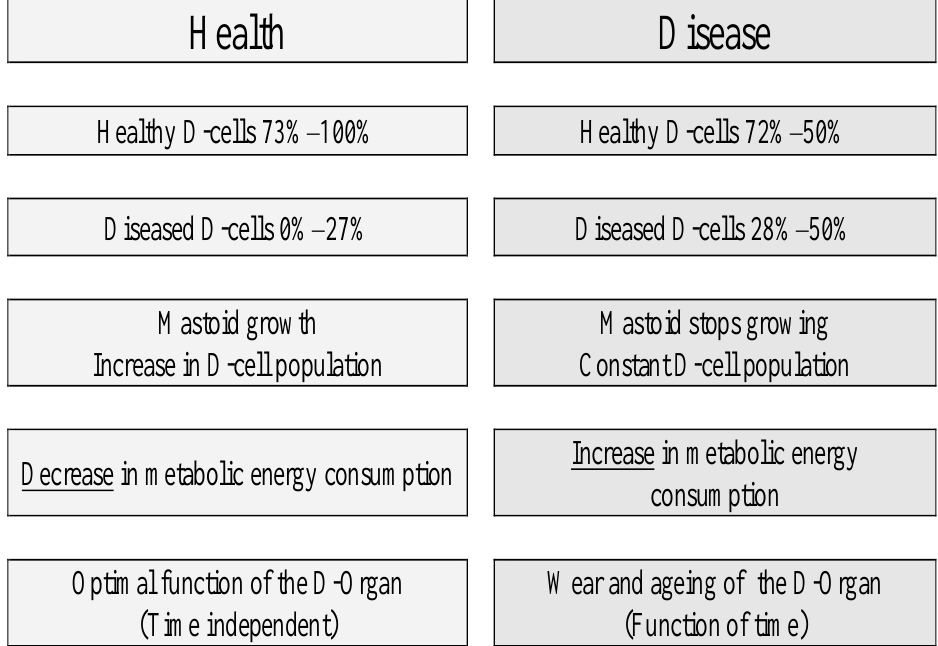
Figure 5. The complementary states of the D-Organ (middle-ear mucosa).